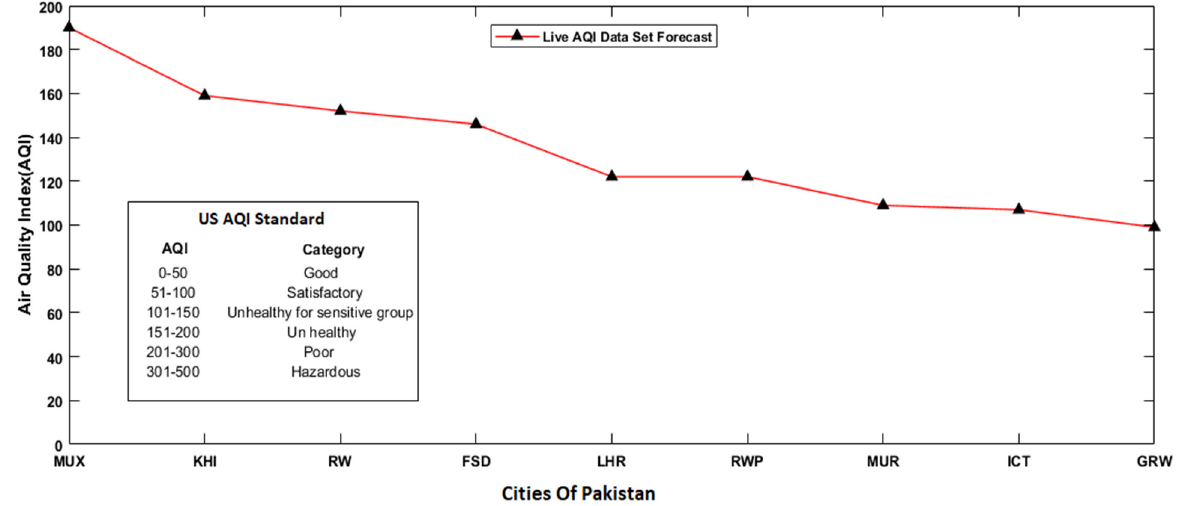
Figure 1. Live Air Quality Index forecast of Pakistan.